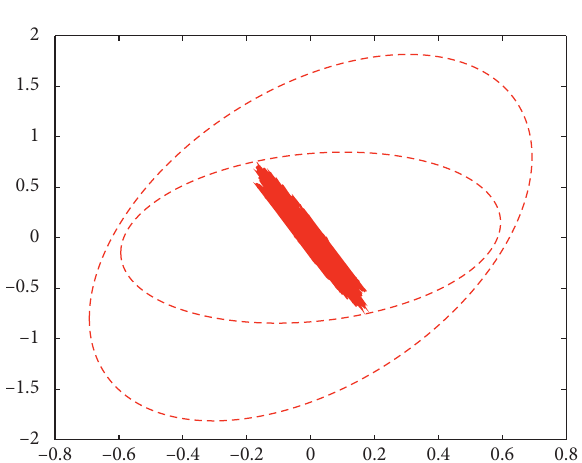
Figure 2: The ellipsoidal bound I and state trajectory of system (58) for Case 1.